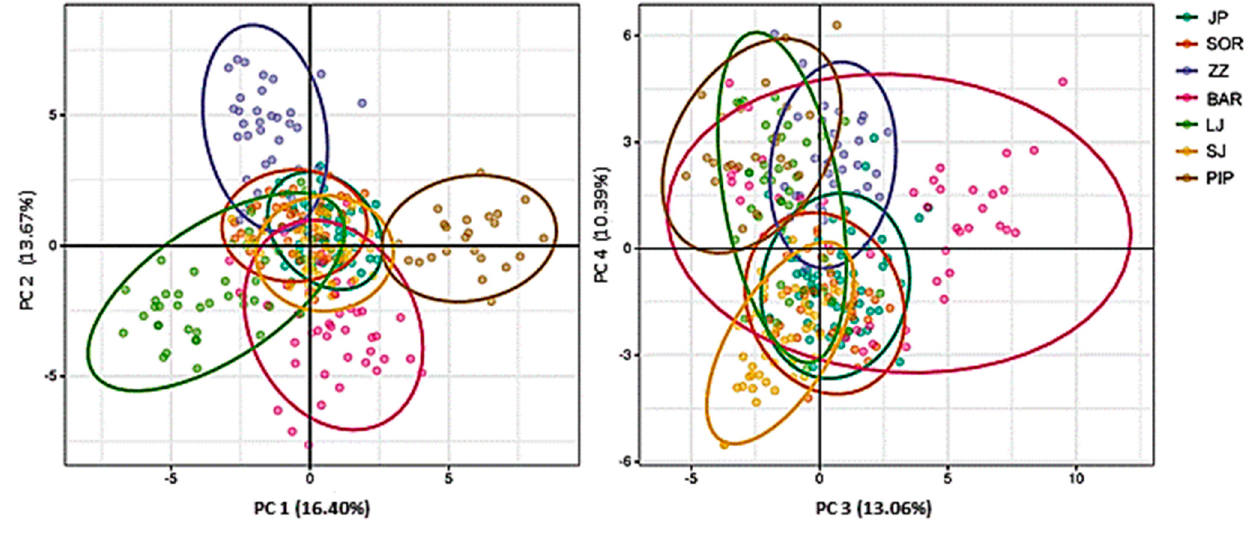
Figure 2. The PCA results of the studied sheep breeds (Abbreviations are listed in Table